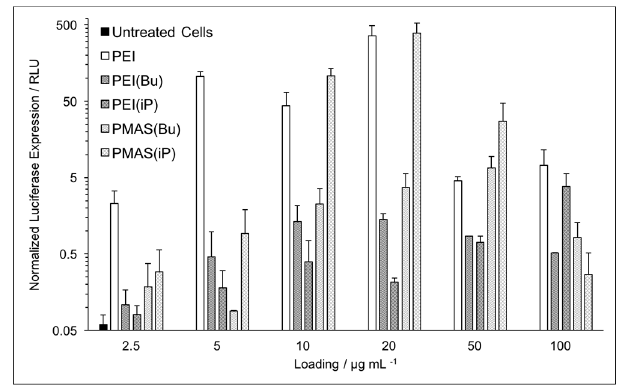
Figure 3. Luciferase expression in HEK-293T cells transfected with pDNA containing the firefly luciferase reporter gene using TAC polymers. Luciferase expression is measured after 48 h incubation with specified polymer loadings (all with pDNA loadings of 3 µ g · mL − 1 ) and normalized by cell count. Error bars show the standard deviation of triplicate measurement.